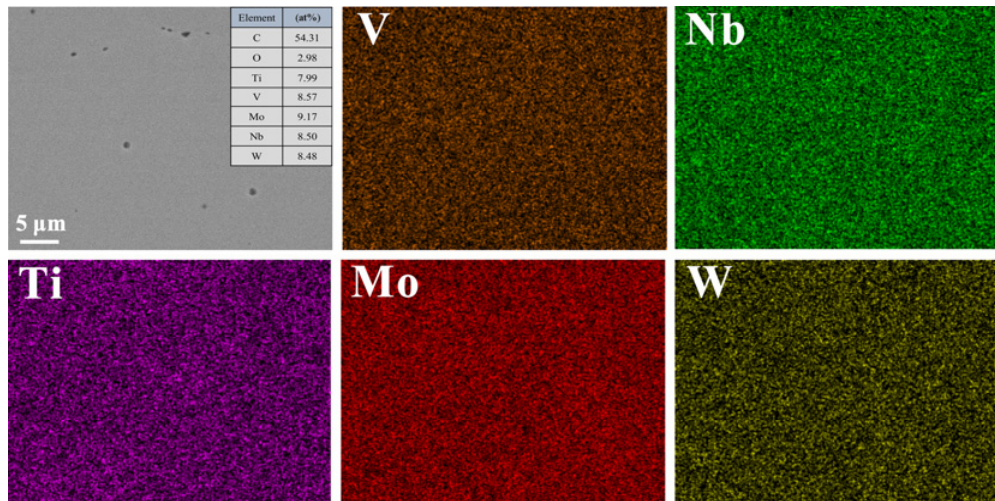
Fig. 3 Morphology of polished surface of sintered high-entropy (TiVNbMoW)C 4.375 and corresponding EDS element distributions.